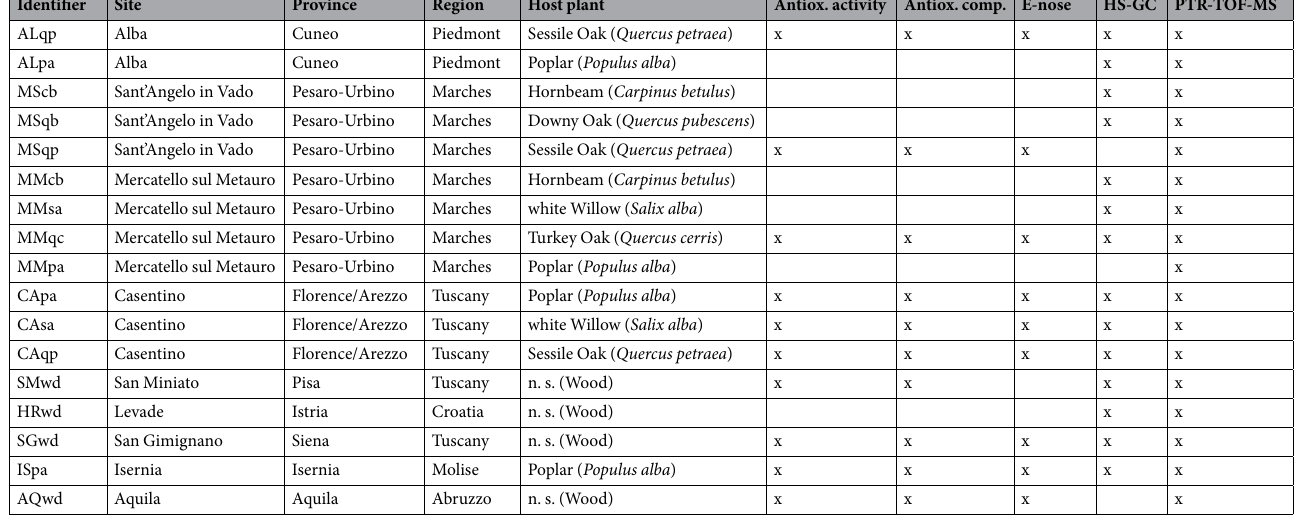
Table 1. Sampling sites, host plants, and analyses performed. All fruiting bodies reached stage 5 of maturation as described in the Materials and Methods section. Identifier: the code used in the statistical analyses; Antiox. activity: the hydrophilic, hydrophobic, and total antioxidant activity assays; Antiox. comp.: glutathione, phenol and ascorbate assays; E-nose: electronic nose